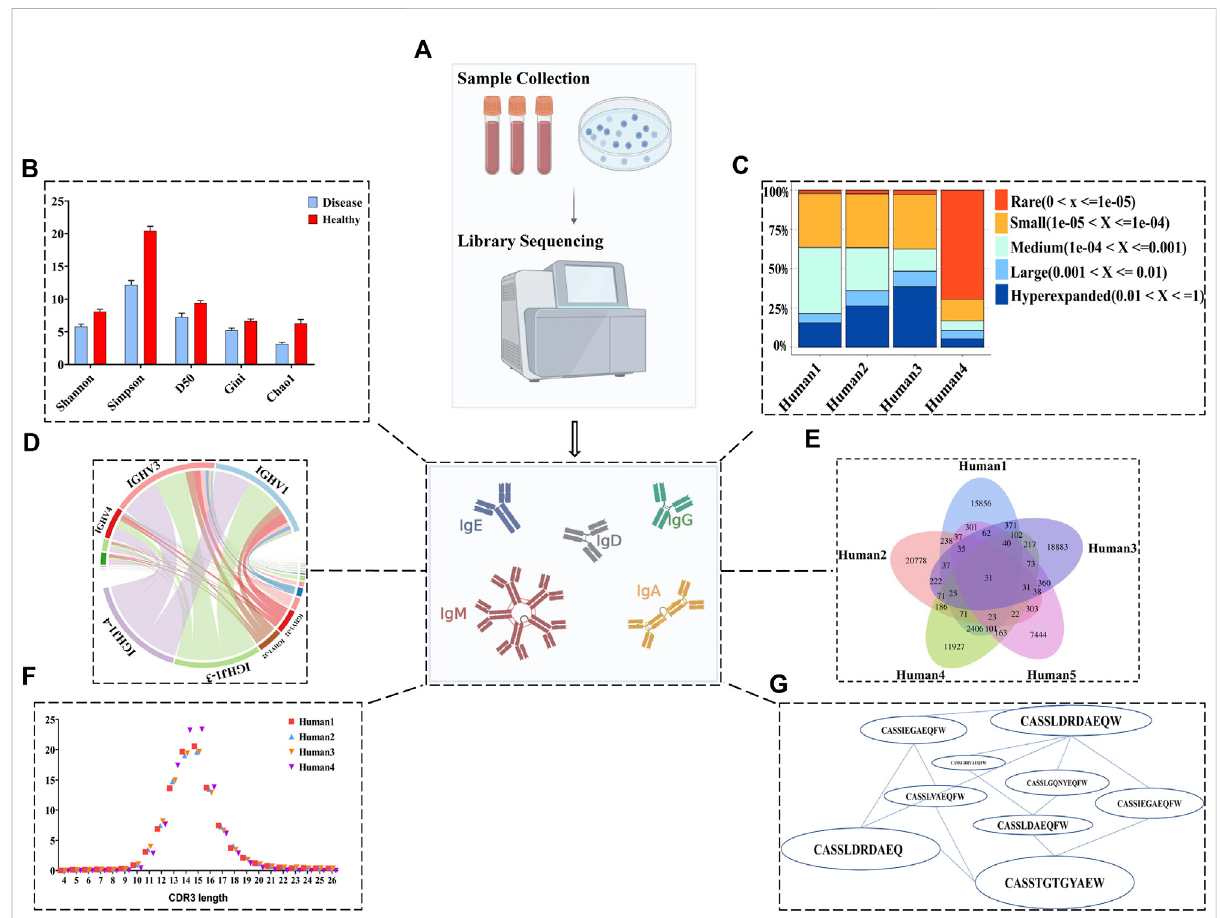
FIGURE 3 BCR repertoire sequence analysis. (A) Sample collection using PBMCs from blood, followed by NGS. (B) The Shannon, Simpson, D50, Gini, and chao1 indices are designed to assess the overall diversity of each cohort. (C) Clone proportion can show the change of high-frequency (clone expansion) as well as low-frequency sequences in each sample. (D) The bias of V and J gene usage and their combination can re fl ect immune responses of different repertoires. (E) The length distribution of the CDR3 region can be used to characterize repertoire. (F) Venn plot can be utilizedfor visualizingthedegree of convergence among samples andexploringthepotentiallydisease-speci fi cpublic clone. (G) Networks